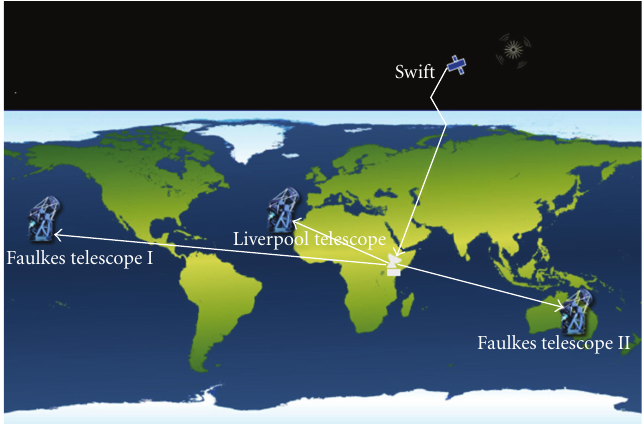
Figure 2: The locations of the 2m robotic Liverpool Telescope and its clones the Faulkes telescopes. GRB triggers from satellites drive prompt automatic followup.